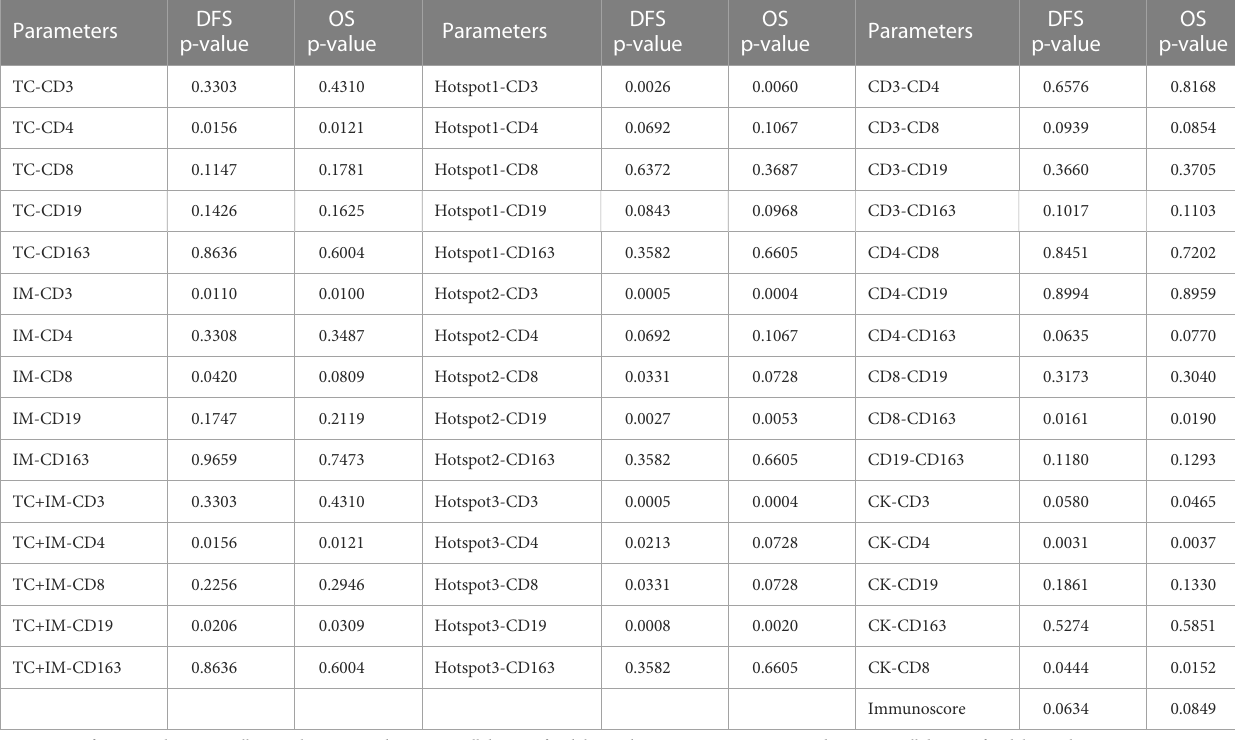
TABLE 4 The survival analysis of all parameters based on cell positive density for the group of IIB and III stage patients.